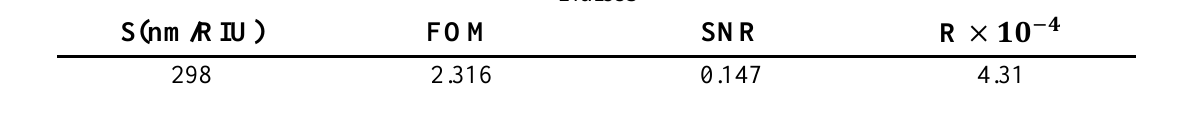
Table 2. Performance parameters for MMF- SPR sensor obtained for different environmental